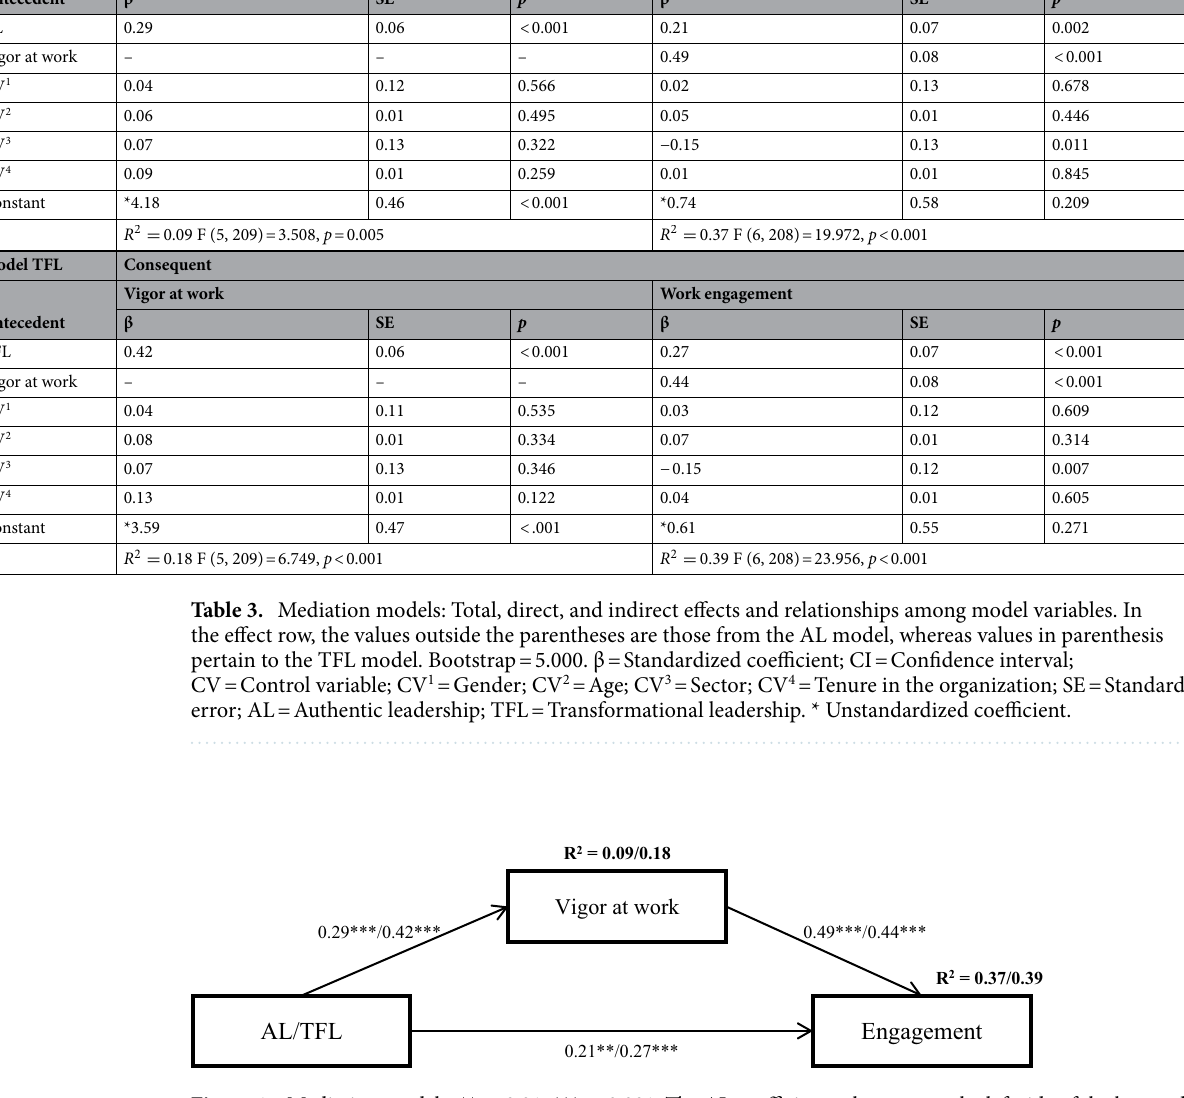
Figure 1. Mediation models. ** p < 0.01; *** p < 0.001. The AL coefficient values are on the left side of the bar, and those of TFL are on the right side. AL = Authentic leadership; TFL = Transformational